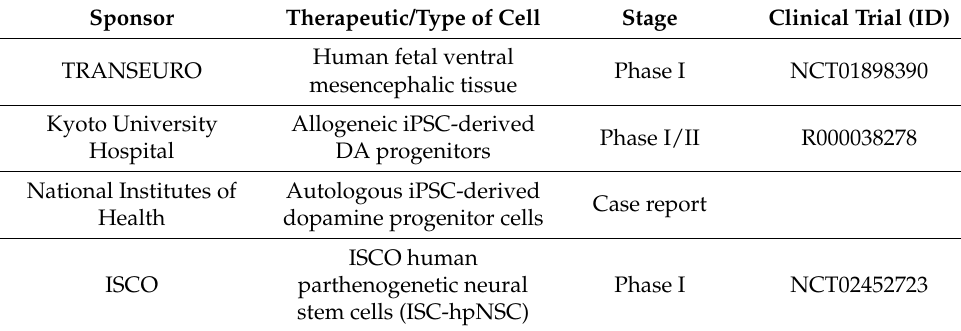
Table 3. State of stem cell-derived dopamine replacement therapies.